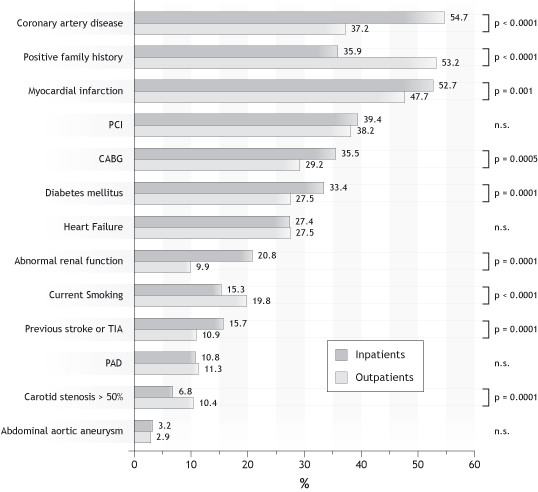
Comorbidities and risk factors in inpatients and outpatients on admission. Coronary artery disease includes one or more of the following: myocardial infarction, percutaneous coronary intervention (PCI), coronary artery bypass graft (CABG). PAD, peripheral arterial disease.